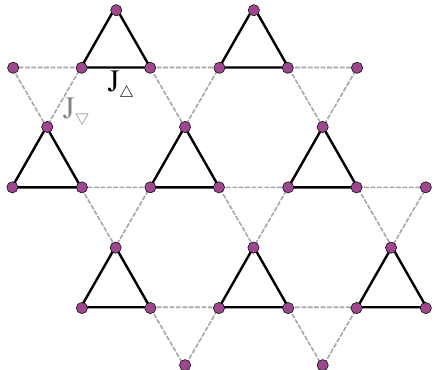
Figure 1: (Color online) Kagome lattice with anisotropic breathing interactions. The AF Heisenberg exchange couplings are different on the edges of upward and down- ward